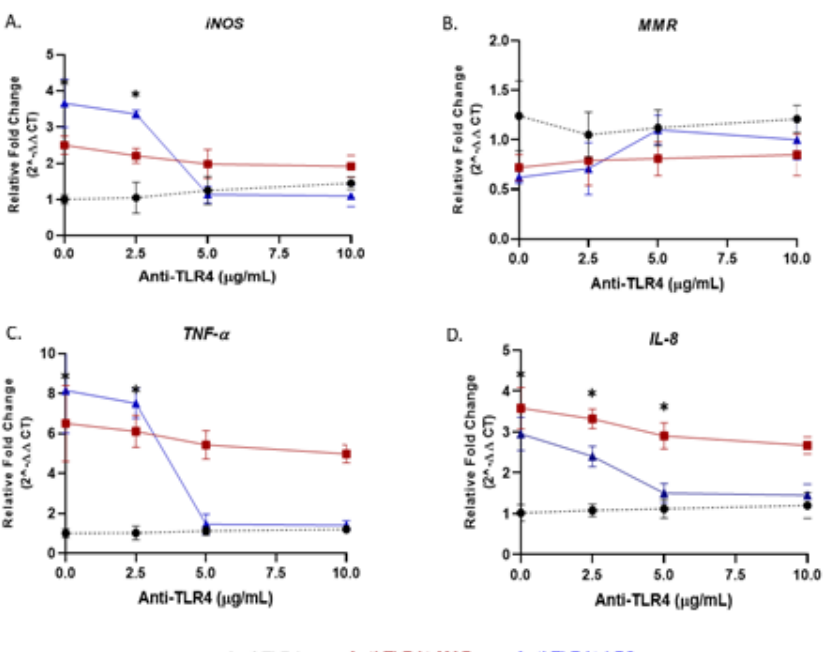
Figure 3. TLR4 antagonist abrogates the macrophage response against LPS but not MAP: M1, M2, TNF-α , and IL-8 studies. THP-1 PMA differentiated macrophages were infected with MAP or treated with LPS for 24 h after pretreatment with 0, 2.5, 5 and 10 µg/mL of TLR4 -IN-C34 (Anti- TLR4 ). Expression of iNOS ( A ), MMR ( B ), TNF-α ( C ) and IL-8 ( D ) were measured by RT-PCR. All experiments were performed in duplicate. * p < 0.05.